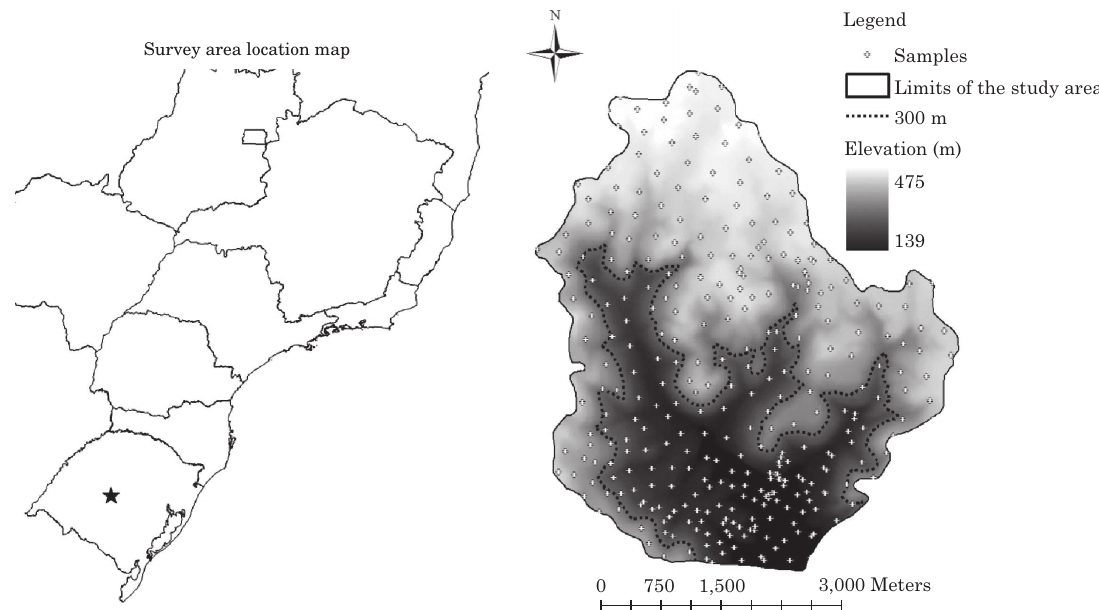
Figure 1. The study catchment: sampling points, delimitation of the upslope and downslope domains and